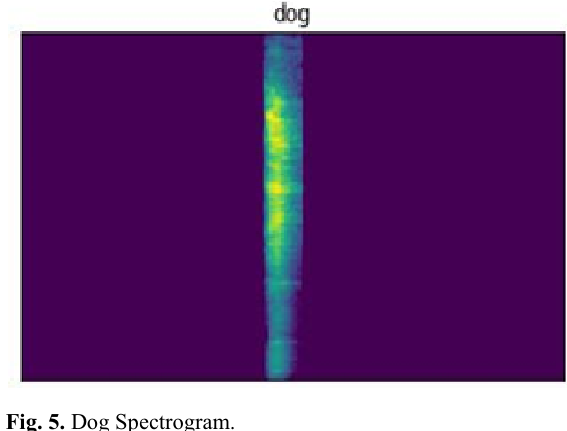
Fig. 4. Dog Waveform